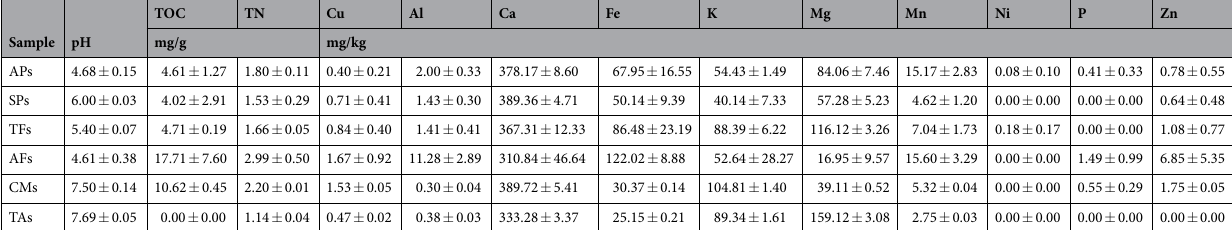
Table 3. The chemical properties of the hyphosphere soils below different types of macro-fungi. TOC, total organic carbon; TN, total nitrogen; Cu, exchangeable copper; Al, exchangeable aluminum; Ca, exchangeable calcium; Fe, exchangeable iron; K, exchangeable potassium; Mg, exchangeable magnesium; Mn, exchangeable manganese; P, exchangeable phosphorus; Zn, exchangeable zinc. Values are mean ± standard